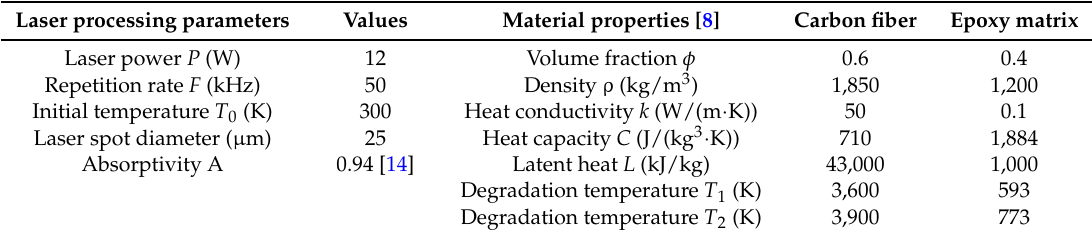
Table 1. Laser processing parameters and material properties of CFRP.